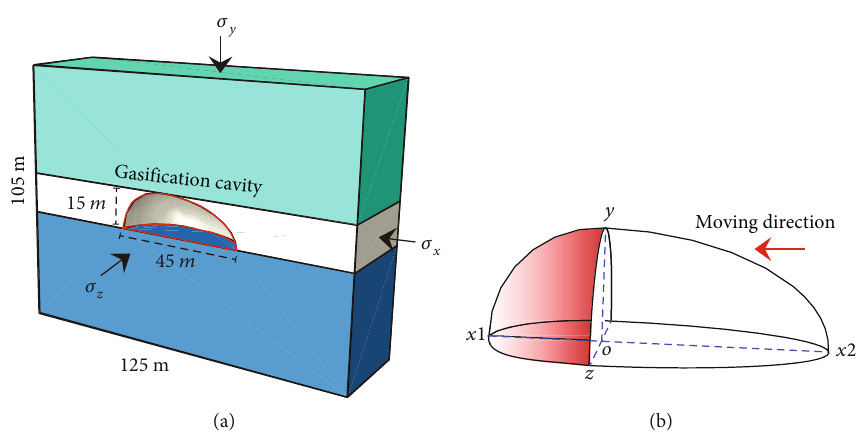
Figure 1: (a) Numerical calculation model. (b) Patterns of combustion